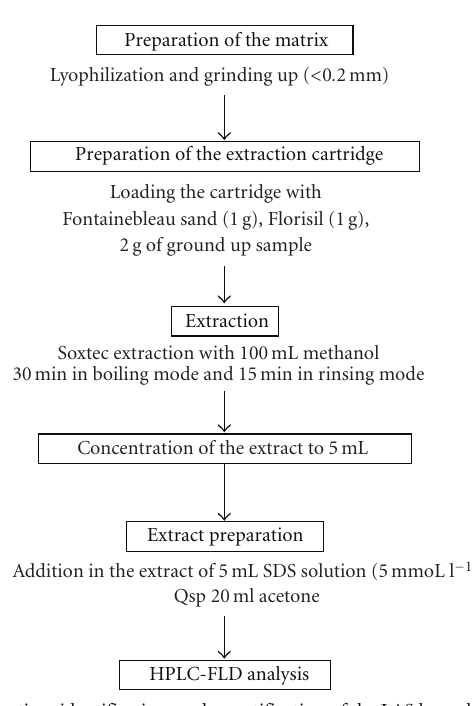
Figure 2: Description of the di ff erent treatment stages for LASs quantitative